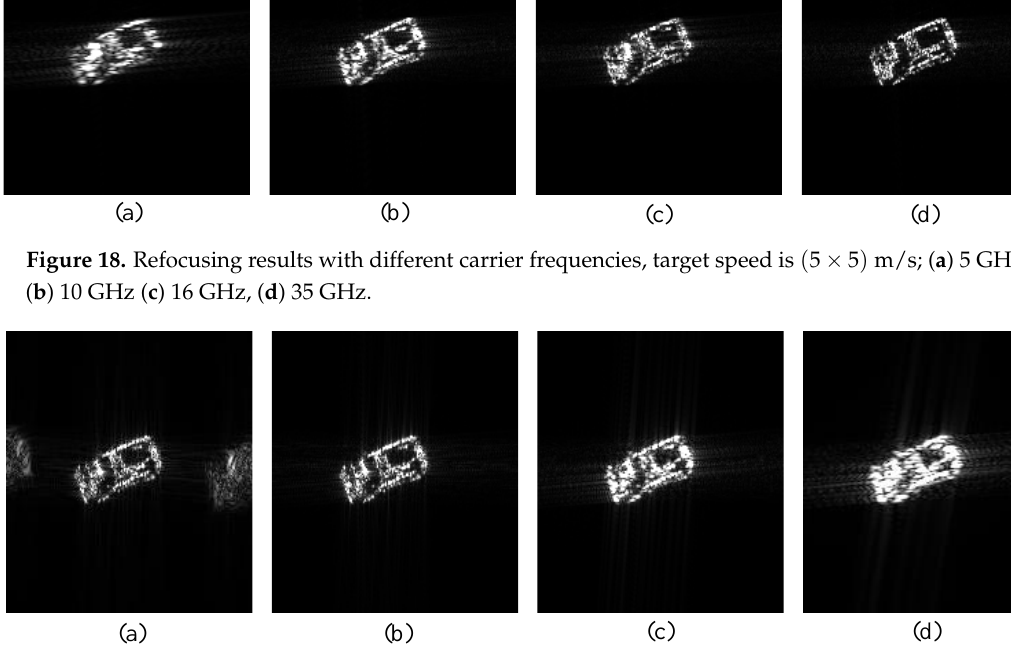
Figure 19. Refocusing results with different target speeds, carrier frequency is 10 GHz; ( a ) ( 1 × 1 ) m/s, ( b ) ( 2 × 2 ) m/s ( c ) ( 5 × 5 ) m/s, ( d ) ( 10 × 10 )